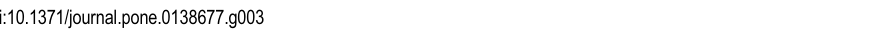
Fig 3. A schematic representation of association map at UGT1A region for total serum bilirubin. The TA repeat location is shown with vertical